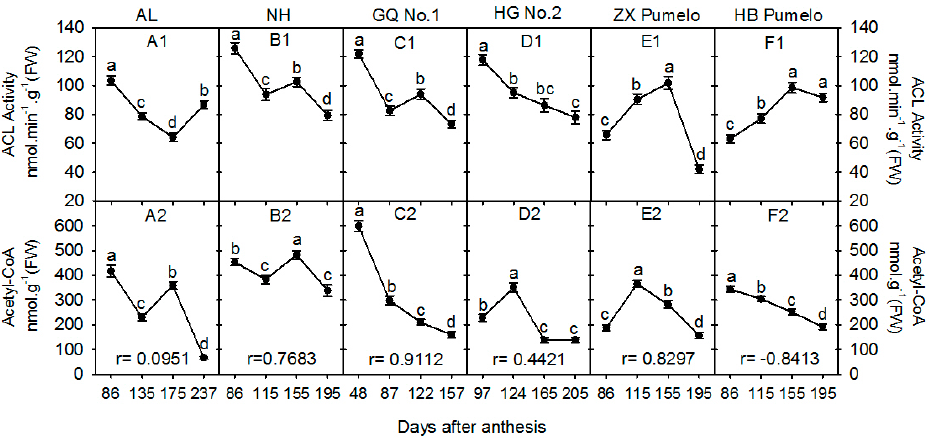
Figure 3. Changes of ATP-citrate lyase (ACL) activity ( A1~F1 ) and acetyl-CoA concentration ( A2~F2 ) in the fruit juice sacs during fruit development and ripening of six citrus cultivars. AL refers to ‘Anliu’ orange. NH refers to ‘Newhall’ navel orange. GQ No. 1 refers to ‘Guoqing No. 1 ′ Satsuma mandarin. HG No. 2 refers to ‘Huagan No. 2 ′ ponkan. ZX pumelo refers to ‘Zaoxiang’ pumelo. HB pumelo refers to ‘HB’ pumelo. Different lowercase letters on the bar in each graph indicate significant differences at p < 0.05 among samples at different stages by Duncan’s multiple range test. r refers to the correlation coefficient between the acetyl-CoA concentration and the ACL activity in each cultivar.